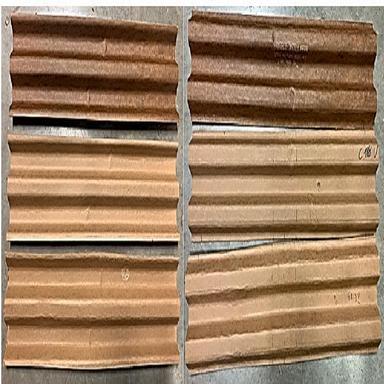
The failure of various corrugated panels under longitudinal bending load.